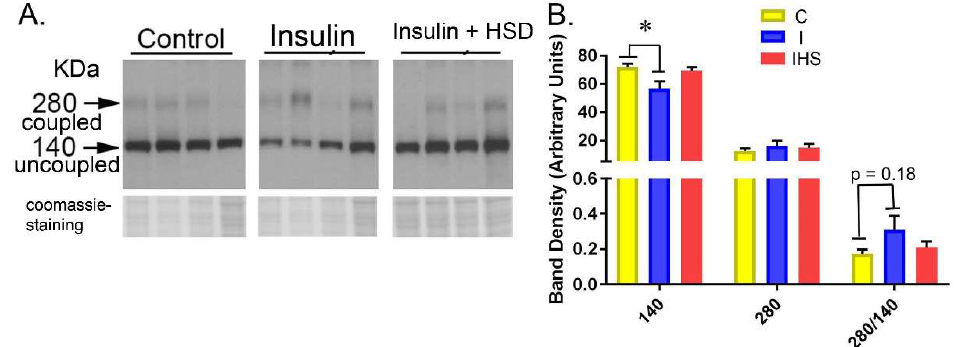
Figure 7. Western blot of eNOS from unreduced samples—( A ) Representative Western blot for eNOS run on cortex homogenates solubilized with Laemmli without dithiotrietol (DTT) and run under non-reducing conditions. Arrows indicate coupled (active, 280 kDa) and uncoupled (140 kDa) bands. ( B ) Band densities summary; * indicates a significant difference between groups by one-way ANOVA ( p < 0.05, mean ± sem; n = 8/group for statistics).